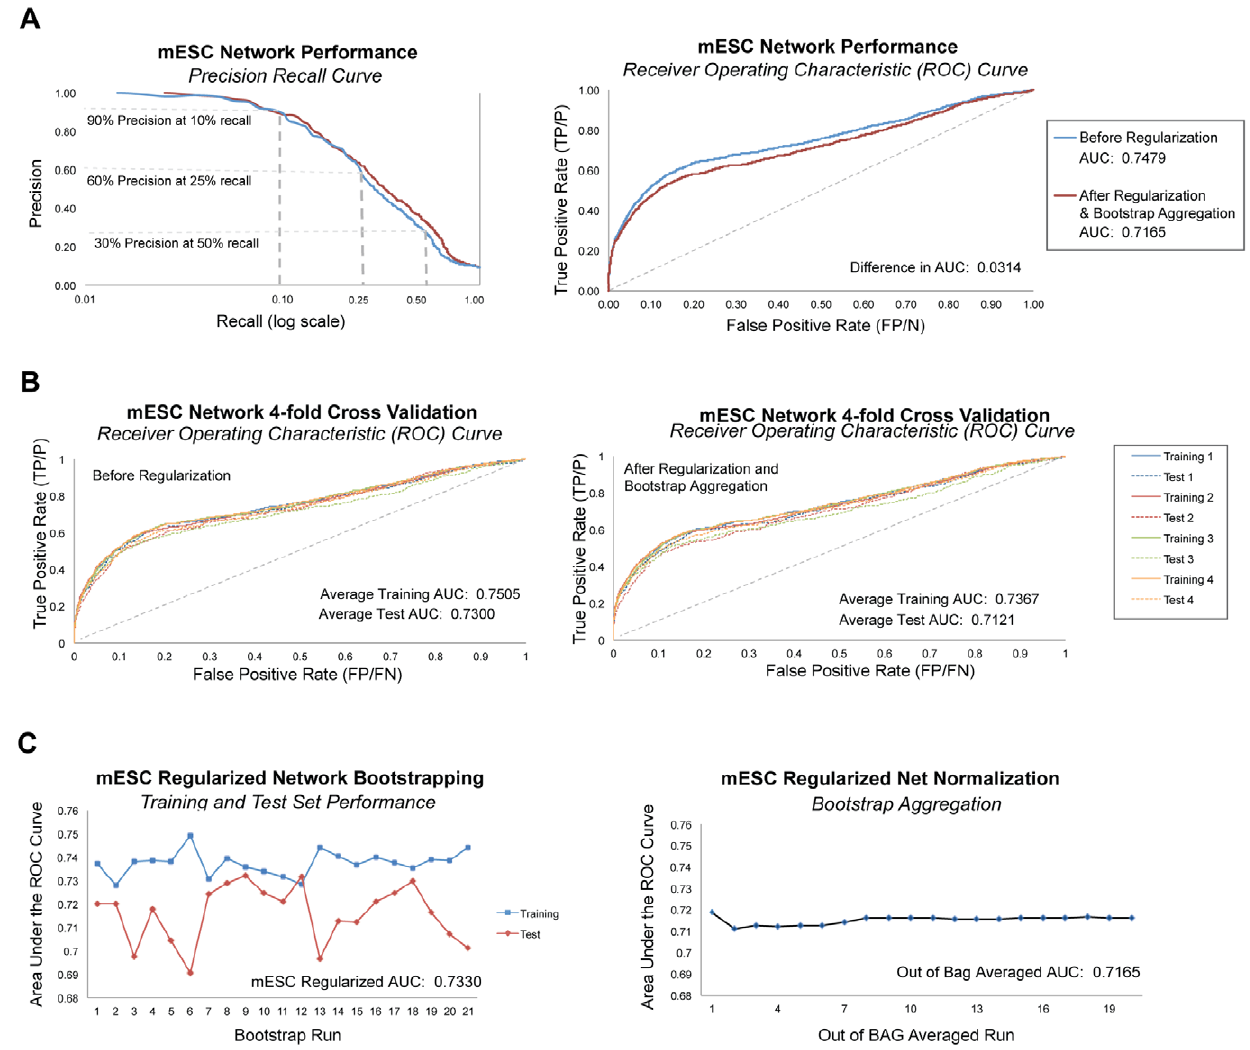
Figure 2. Cell-Type-Specific Data Integration and Machine-Learning Methodology. Our approach is designed to generate reliable and relevant predictive biological networks using high-throughput data limited to a specific cell type and a training gold standard focused on biological processes active in that cell type. This process can be distilled into four basic steps: 1. Collect and standardize cell-type specific data from studies using diverse high-throughput experimental techniques, including microarray gene expression, chromatin immunoprecipitation (ChIP) on chip (ChIP- Chip), ChIP followed by high-throughput-sequencing (ChIP-Seq), affinity purification followed by mass spectrometry (AP-MS), whole-genome small interfering RNA (siRNA) screens, and phylogenetic sequence similarity. For this case study, we focused on mouse embryonic stem cell (mESC) data. 2. Curate a process-specific gold standard training set to provide a baseline for assessing data reliability and significance for related biological processes known to be active in the cell type of interest. Our gold standard training set consists of experimentally validated pair-wise associations between genes and proteins known to be involved in mESC self-renewal, pluripotency, and cell fate determination. 3. Iteratively test and validate networks. A. Use a naı¨ve Bayesian network classifier to perform inference and predict novel gene and protein relationships. Our network predicts pairwise functional associations that influence mESC self-renewal and early developmental processes. B. Validate the accuracy of predicted functional relationships using standard machine learning performance metrics, cross validation, and bootstrapping, followed by evaluation of biological content. Our protocol for assessing networks ensures our results are highly reliable and relevant to mESC self-renewal. 4. Provide community access to analyses and tools. Through StemSight.org, we provide access to network analyses and visualization tools to enable users to further explore